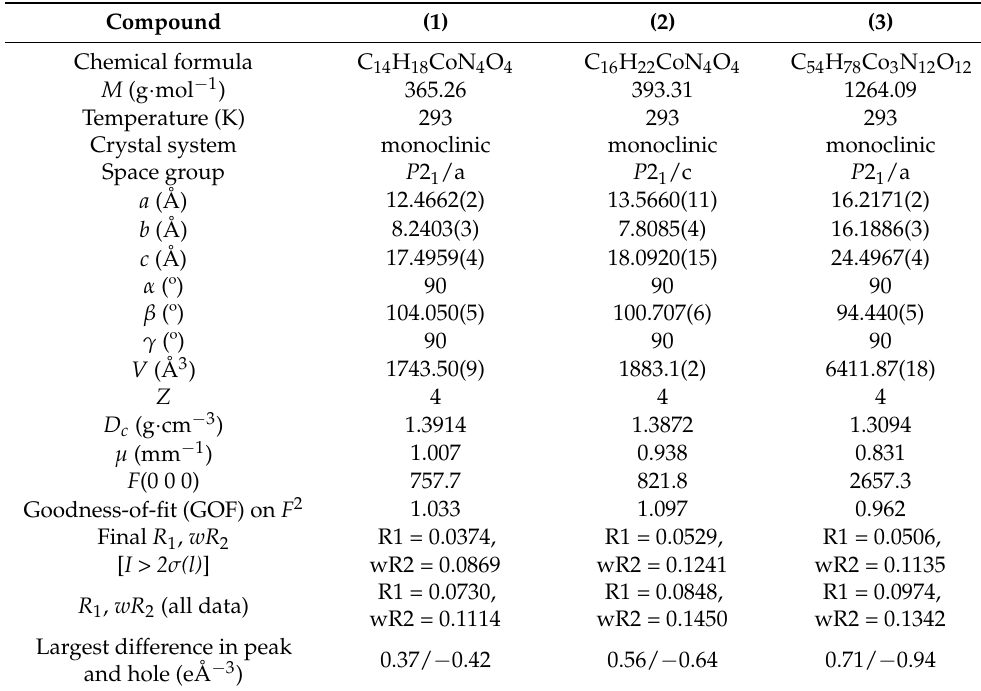
Table 1. Crystal data and structure refinement for compounds ( 1 )–( 3